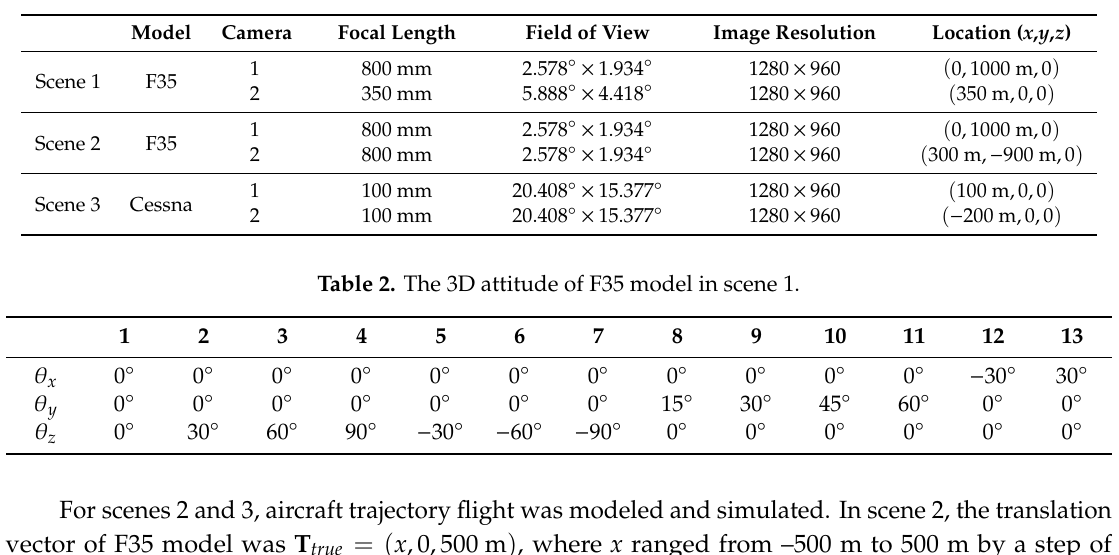
Table 1. The detailed information about the simulation scenarios.